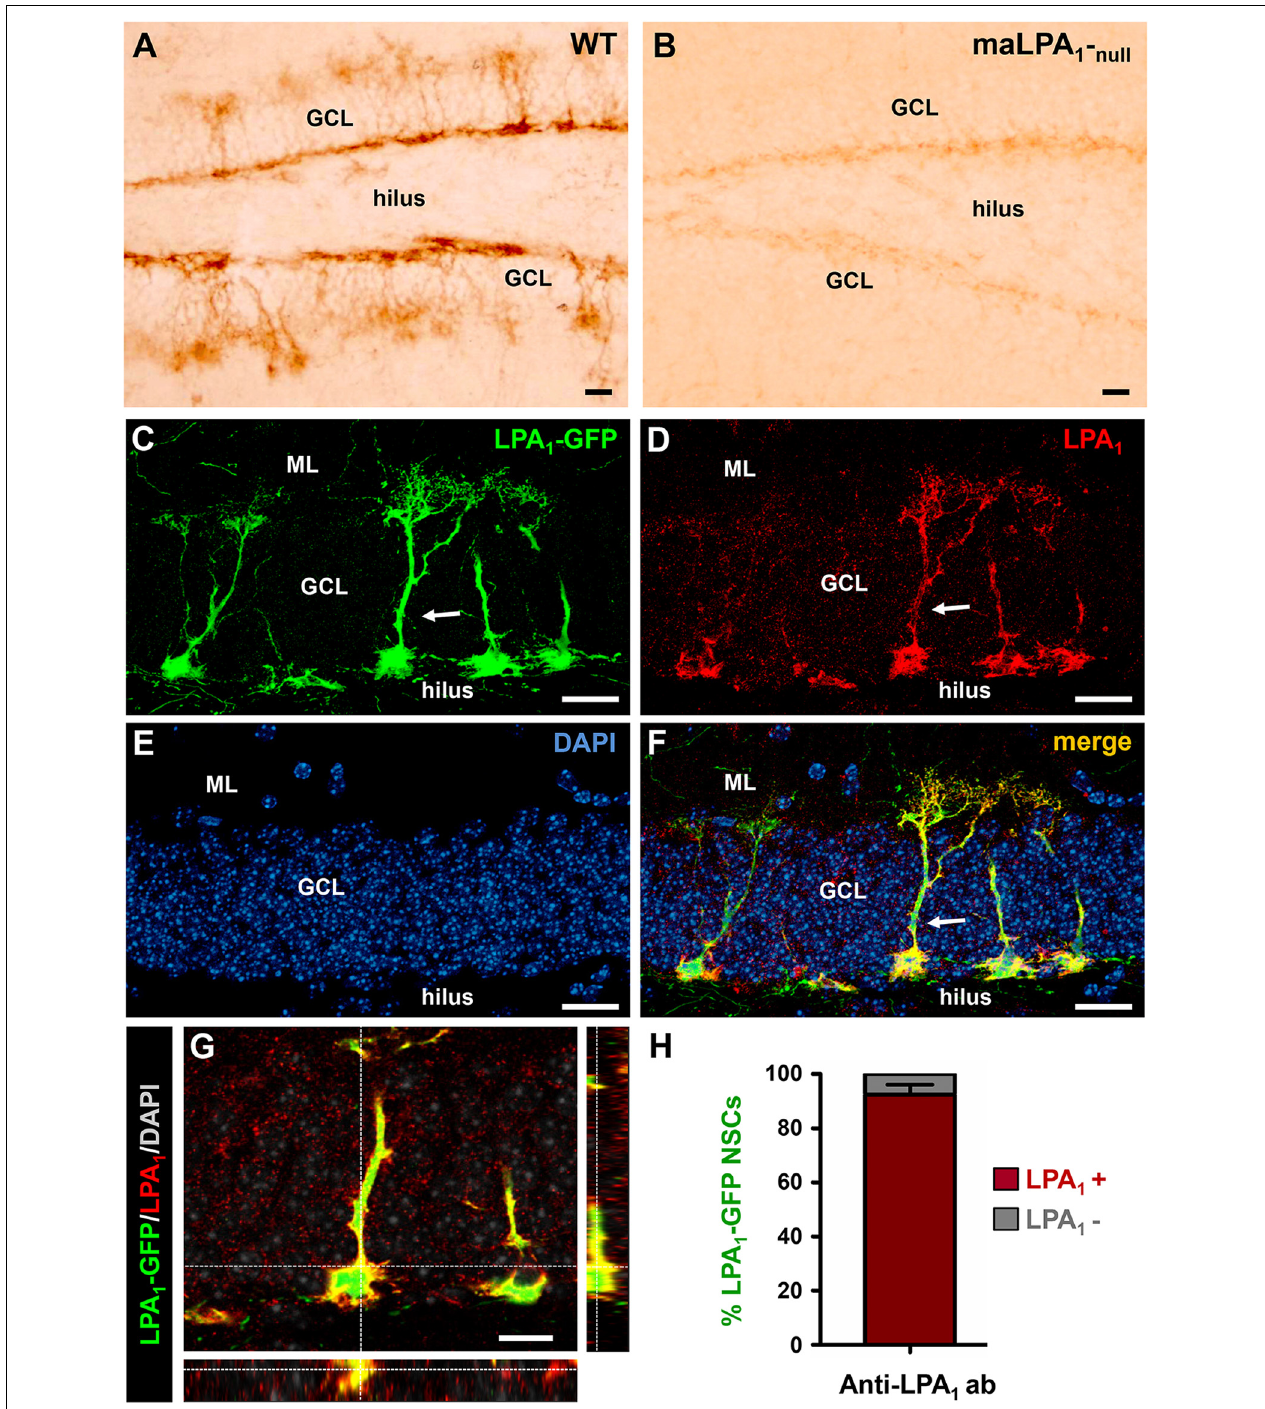
FIGURE 1 | Lysophosphatidic acid receptor 1–GFP expression colocalizes with LPA 1 immunostaining and specifically labels hippocampal NSCs. Immunostaining with an anti-LPA 1 antibody labels NSCs in the DG (A) . When the same antibody is used in the maLPA 1 -null mouse, in which only a truncated non-functional form of LPA 1 is expressed, staining is almost absent (B) . Immunostaining with the anti-LPA 1 antibody in slices from the LPA 1 -GFP transgenic mouse shows almost total colocalization. Confocal microscopy imaging was used to analyze colocalization in z-stack projections of the LPA 1 -GFP signal (C) with the anti-LPA 1 immunostaining (D) . DAPI staining was used for better anatomical resolution (E) . The merged image is shown in (F) , and an orthogonal projection demonstrating full colocalization is shown in (G) . The quantification showing the almost 100% colocalization of LPA1-GFP and LPA1 immunostaining in NSCs is shown in (H) . Scale bar is 20 µ m in all